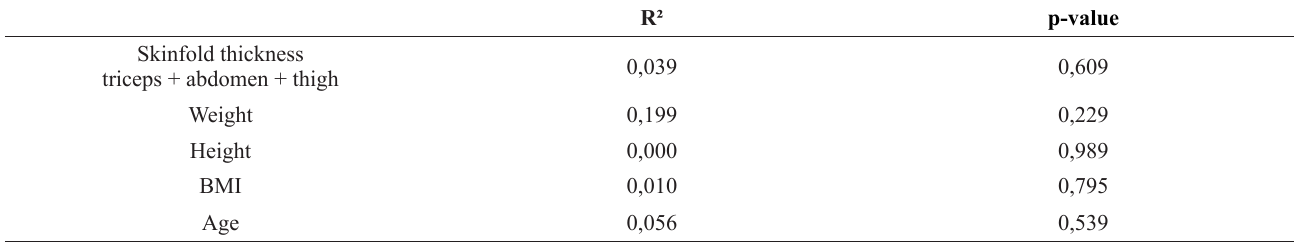
Table 2 - Univariate linear regression in the pre-menarche group with motor performance (time trial) as a dependent variable.